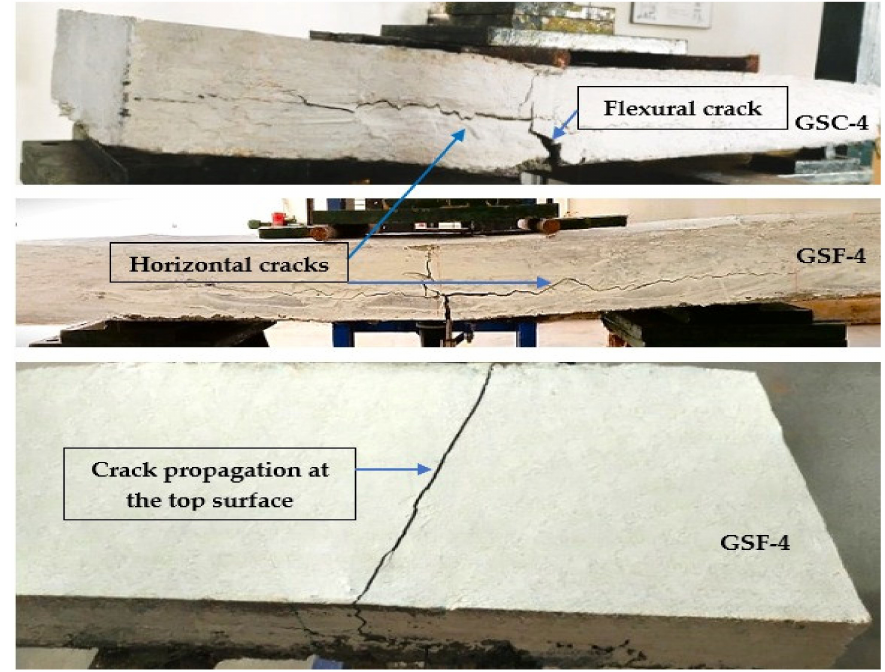
Figure 7. Crack propagation and the failure modes Mode-IV slab specimens. Table 4. Summary of test results of the slab